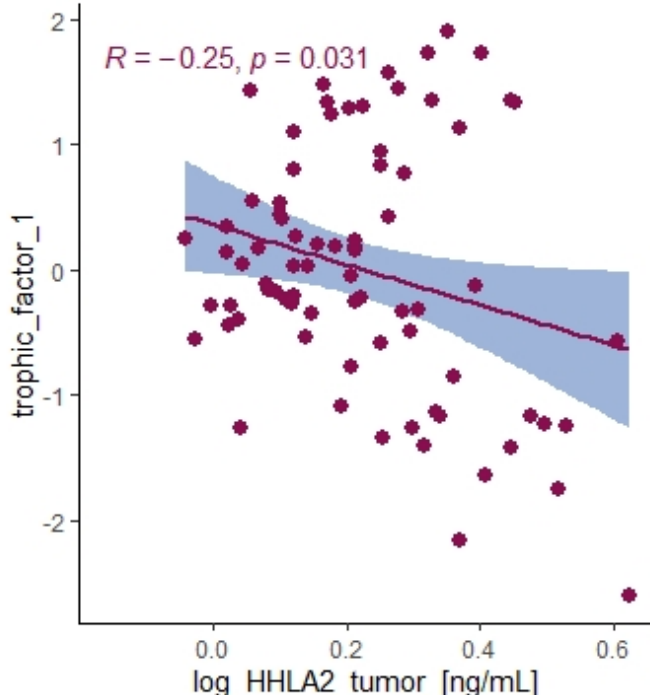
Figure 6. Loading plot presenting loading factors after varimax rotation to change positioning vec- tor of the factors and provide easier interpretation of factor loadings.